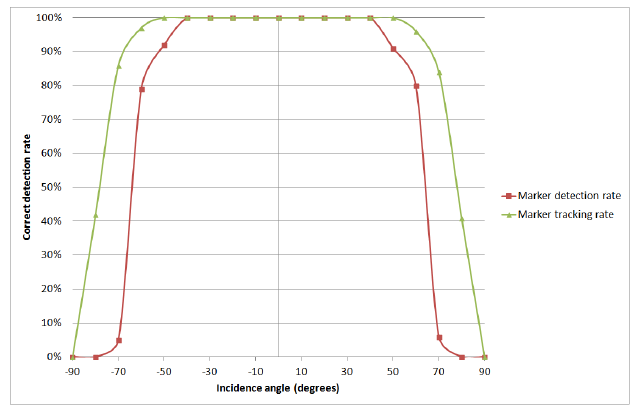
Figure 18. Dynamic marker detection rate versus camera incidence